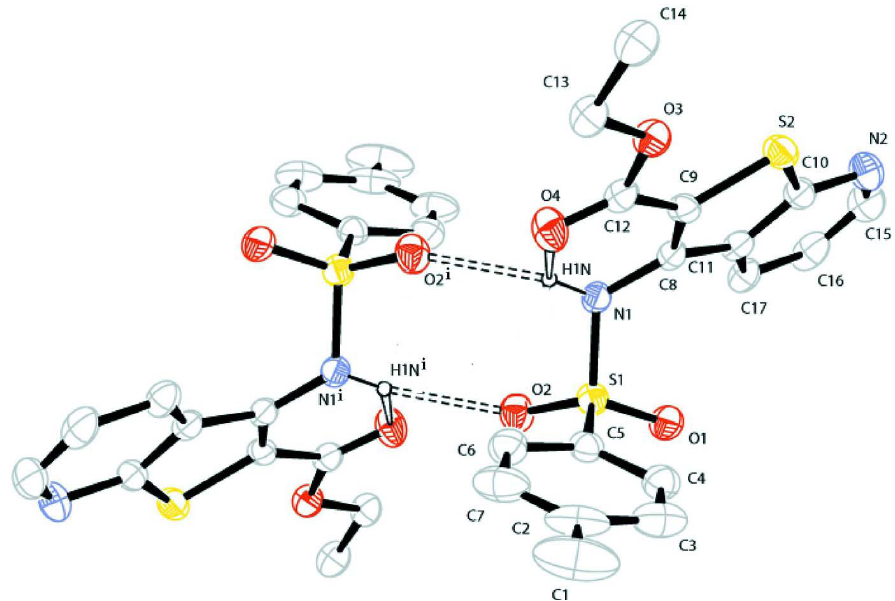
Figure 2 View of the dimeric structure in the title compound. Hydrogen bonds are shown as hollow bonds (intermolecular ones as dashed lines, intramolecular ones in full lining). Symmetry code: (i) -x, -y+1,